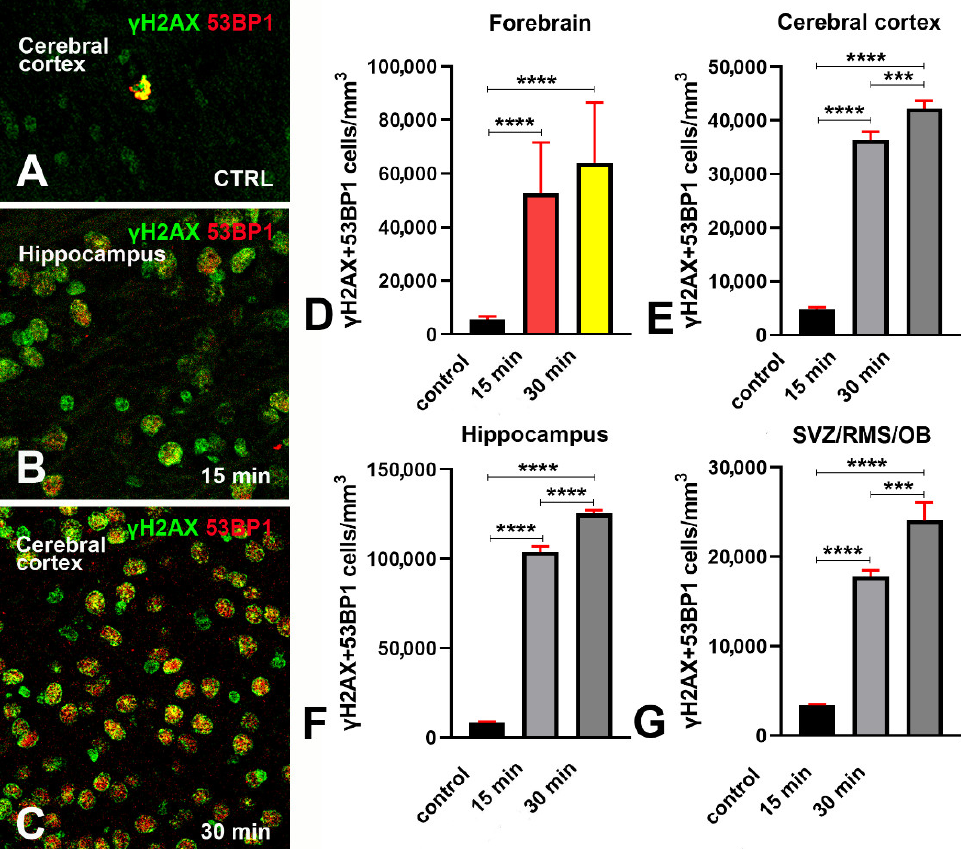
Figure 6. γ H2AX + 53BP1 double-labeling experiments in the forebrain of control and irradiated mice. ( A ) exemplificative image of the pattern of immunostaining in the cerebral cortex of a control nonirradiated mouse. Note the double-labeled cell displaying immunoreactive foci singularly labeled for γ H2AX (green) or 53BP1 (red) and foci of dual immunoreactivity (yellow). ( B ) exemplificative image of the pattern of immunostaining in the hippocampus of a mouse that survived 15 min after irradiation. Note the high number of immunoreactive cells, some of which display distinct nuclear foci of γ H2AX (green) or 53BP1 (red) immunoreactivity. ( C ) exemplificative image of the pattern of immunostaining in the cerebral cortex of a mouse that survived 30 min after irradiation. Note that most of the cells are double-labeled and display numerous yellow foci of immunoreactivity indicative for γ H2AX (green) + 53BP1 colocalization (red). Original magnifications 40 × . ( D – G ) Quantitative analysis of the volumetric density of double-labeled cells, in the whole forebrain, cerebral cortex, hippocampus, and SVZ/RMS/OB. Data are expressed as mean ± 95% CI. *** 0.001 > p ≥ 0.0001, **** p < 0.0001. Bars are 95% CI. Staining for γ H2AX was performed using the Upstate primary antibody. For numerical data of statistics see Table